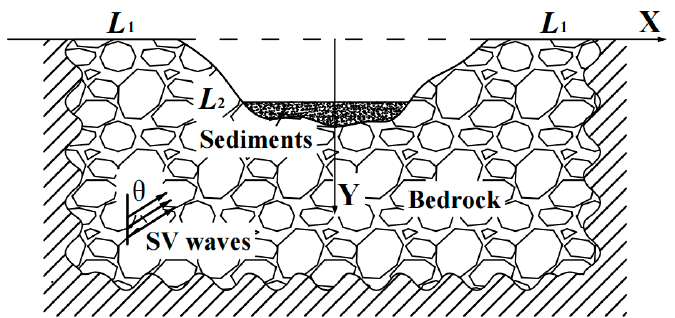
Figure 1. Calculation